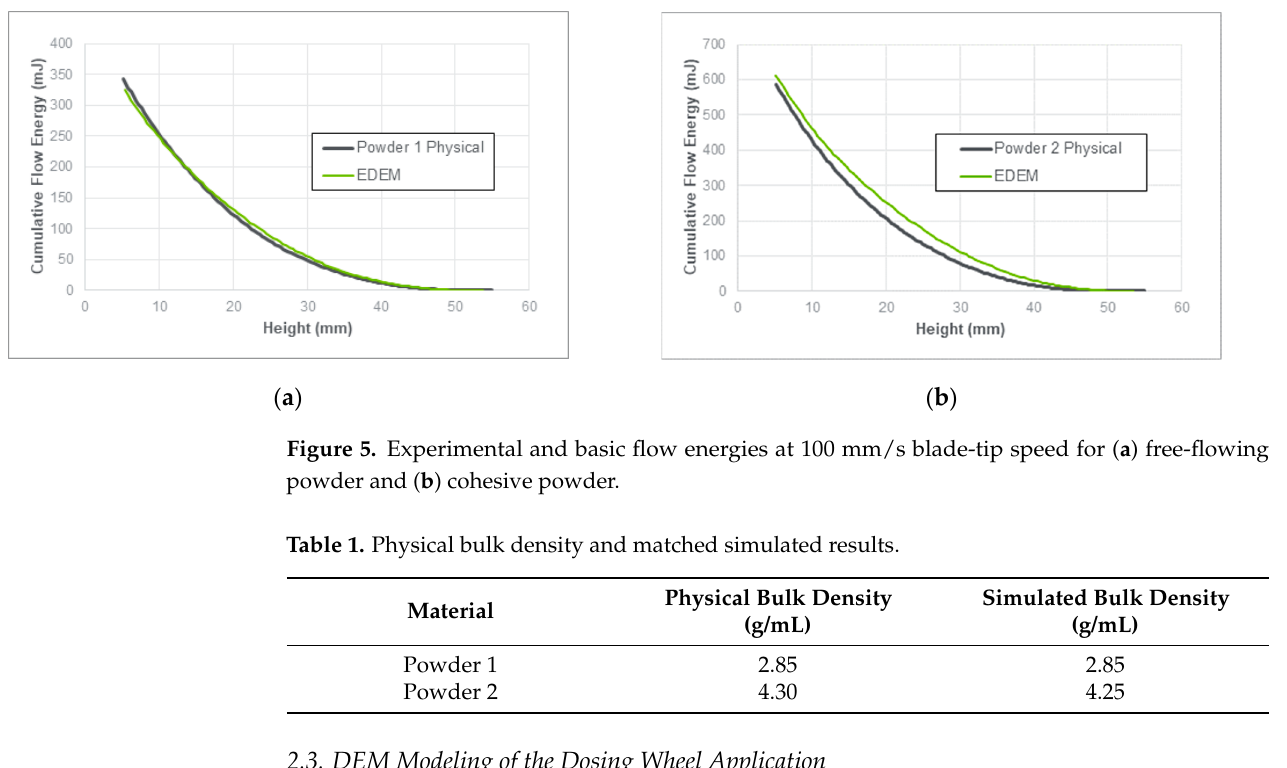
Figure 4. Experimental and simulated torques on the impeller blade during the basic flow energy